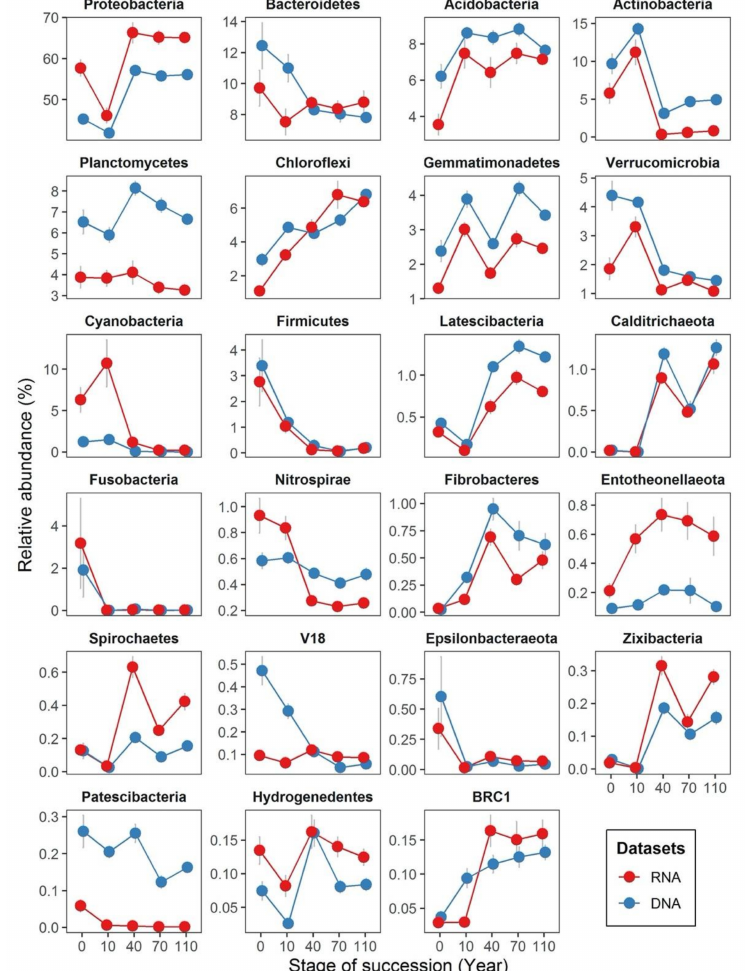
Figure 4. Line plots displaying the dynamic changes in relative abundances of bacterial phyla (mean relative abundance > 0.1%) based on DNA- and RNA-inferred communities. The x -axis displays successional stages in years (i.e., 0, 10, 40, 70 and 110 years of succession), and the y -axis displays the phyla relative abundance (in % of the total abundance). Points indicate average, and error bars represent standard errors from the